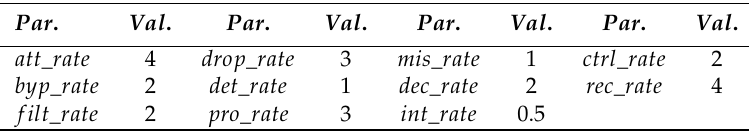
Table 5. Parameters of the SPN